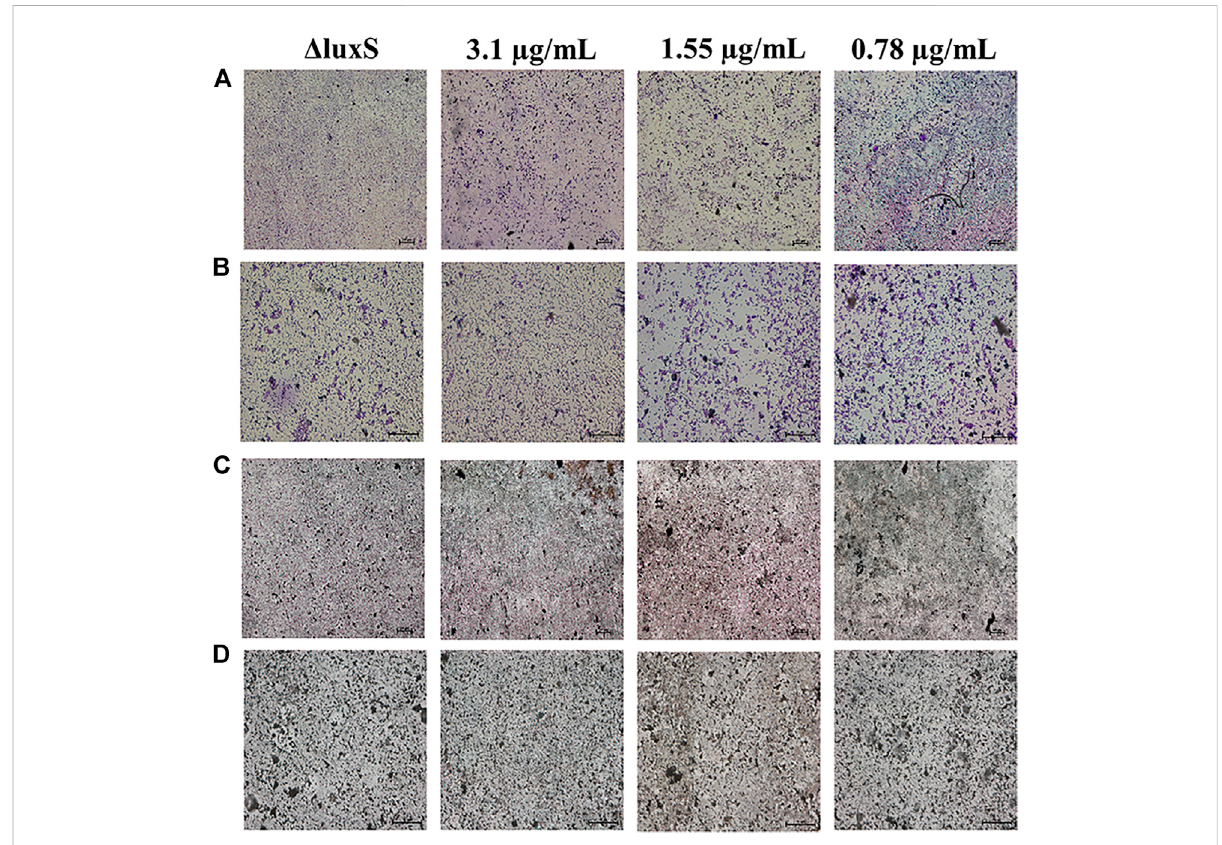
FIGURE 4 Effect of non-inhibitory concentrations of 1,8-cineole on the microstructure of bacterial bio fi lms of E. coli O101 with deletion of luxS gene. (A – D) Effect of non-inhibitory concentrations of 1,8-cineole on the amount of bio fi lm formation of E. coli O101 without luxS gene under light microscopy. (A , B) Crystalline violet staining: 100× and 400×; (C , D) Silver staining: 100× and